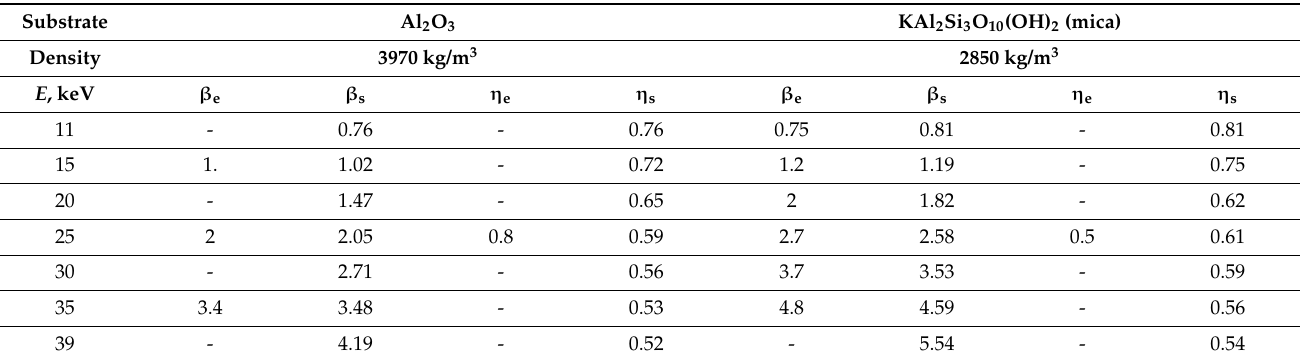
Table 3. Comparison of the parameters of the proximity function obtained in the experiment β e , η e and as a result of calculating β s , η s for different energies of electrons E , Al 2 O 3 substrates and mica. The PMMA resist (ERP-40) 0.5 µ m thick.